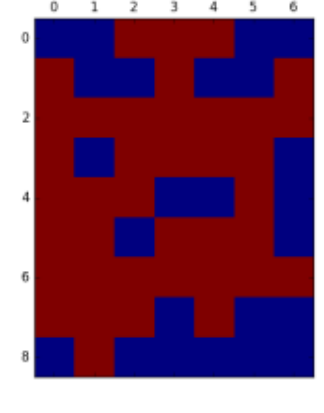
Figure 6. Simple test case – low threshold for inclusion in storm element